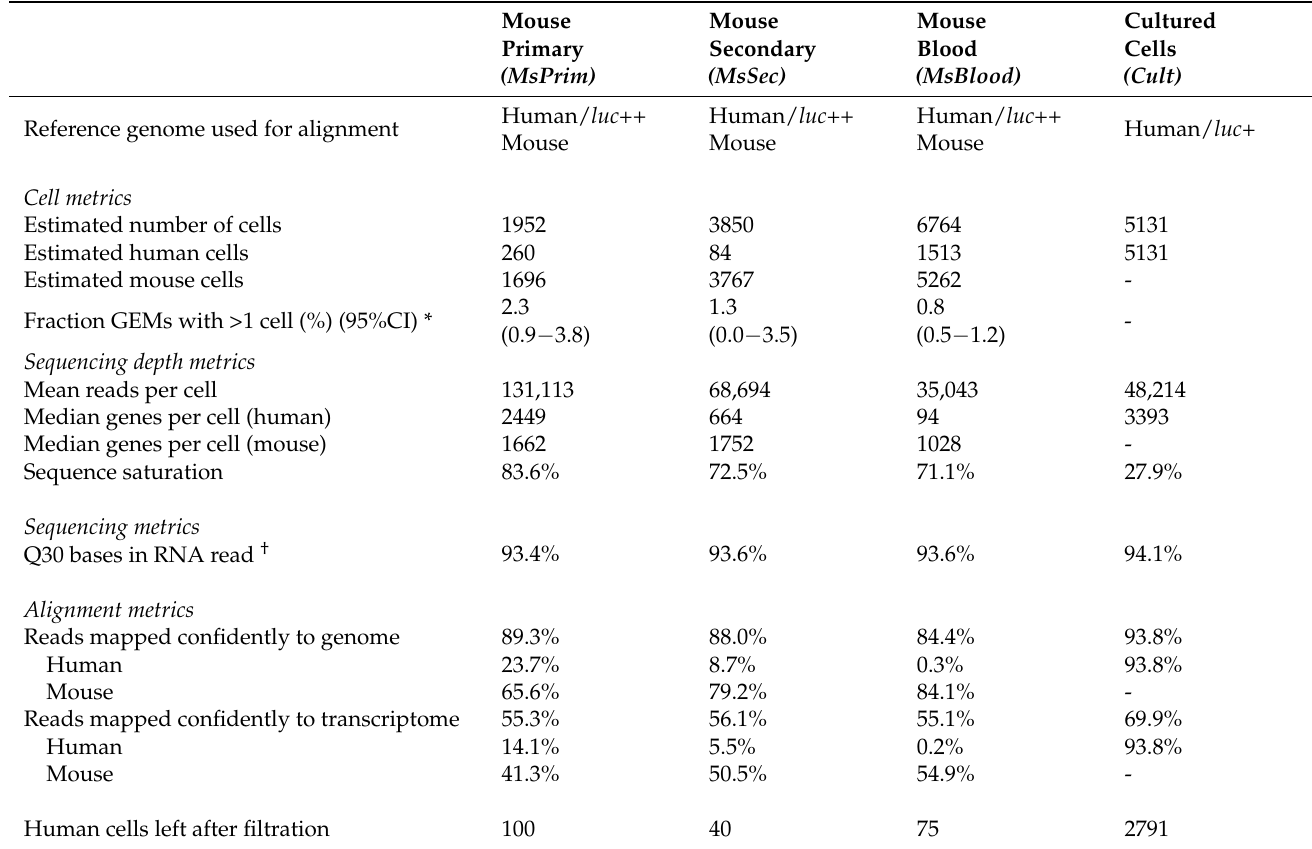
Table A1. Basic sequencing and alignment metrics for the four